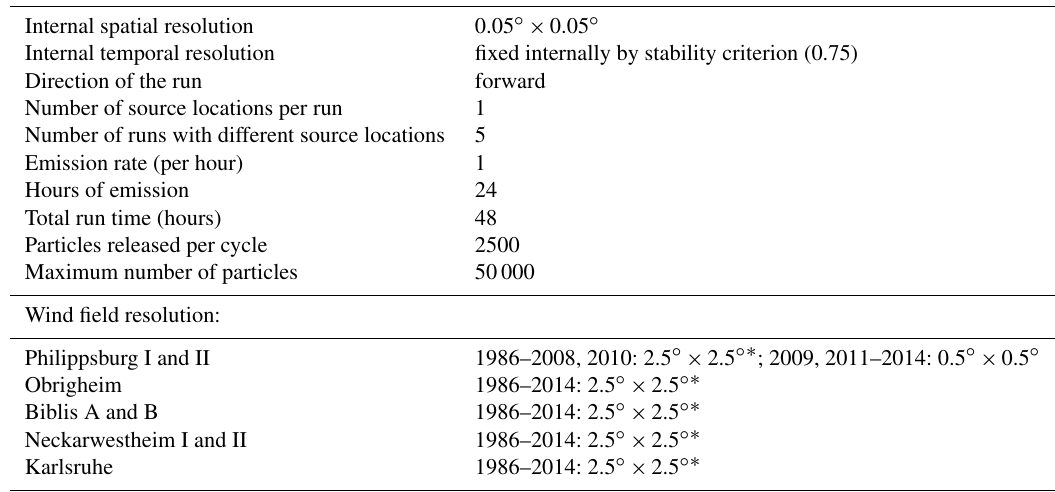
Table 2. Control parameters of the HYSPLIT runs and used wind field data for 14 CO 2 contamination estimates for the different nuclear facilities.